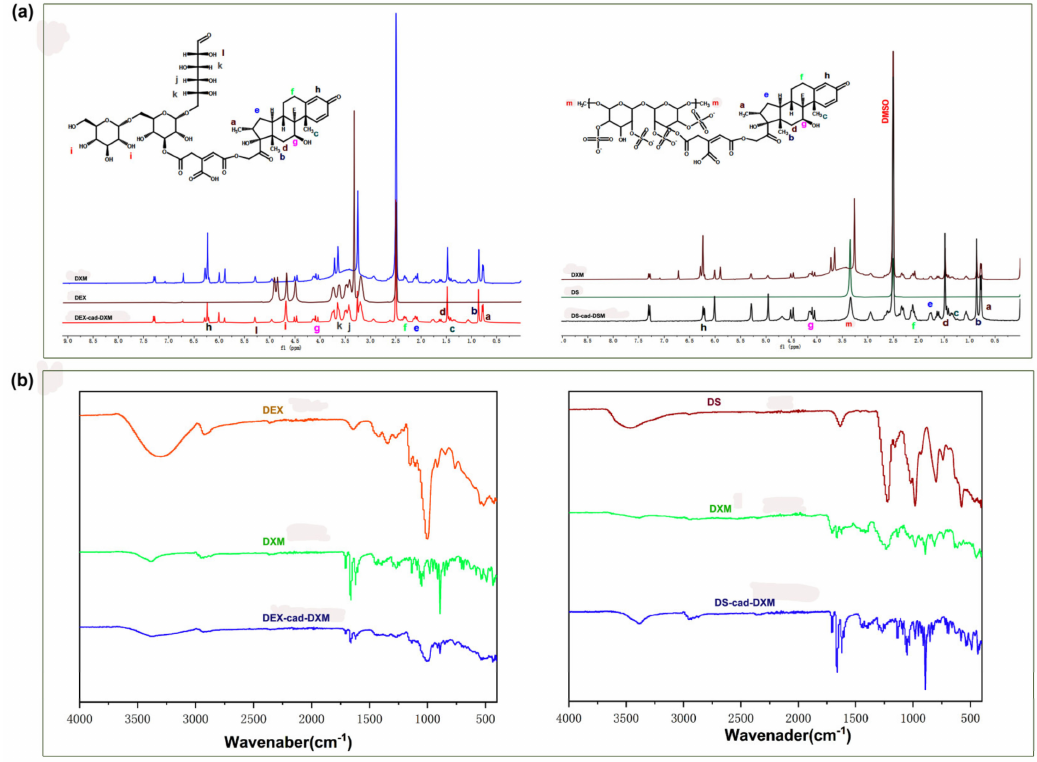
Figure 1. 1 HNMR spectra of DEX-cad-DXM and DS-cad-DXM ( a ) conjugates. FT − IR spectra of DEX-cad-DXM and DS-cad-DXM ( b )